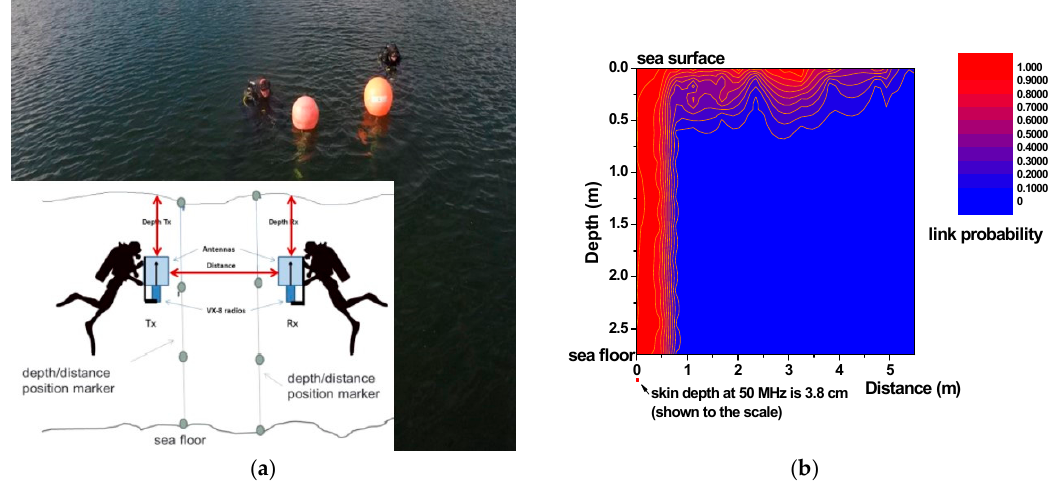
Figure 9. ( a ) Photo of the underwater test range used in our experiments. The inset shows experimental configuration; ( b ) Contour plot of the link probability measured in seawater as a function of diver depth and distance between the divers. The sea floor was located at 9 m depth. The skin depth at 50 MHz in seawater is shown to the scale.